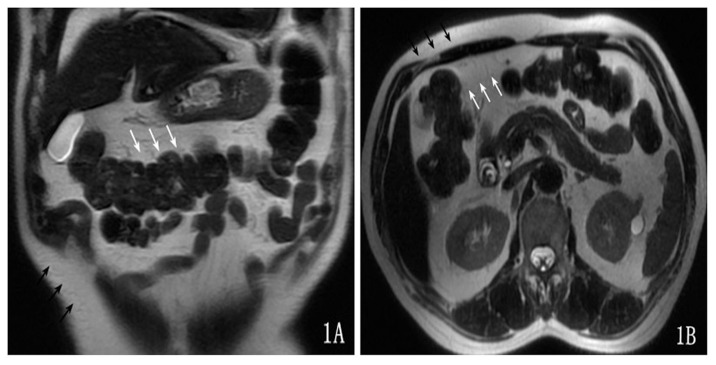
The signal intensity of the transverse-mesocolon adipose tissue was uniform (white arrow) and consistent with the subcutaneous fat (black arrow) signal on the T2-weighted image.